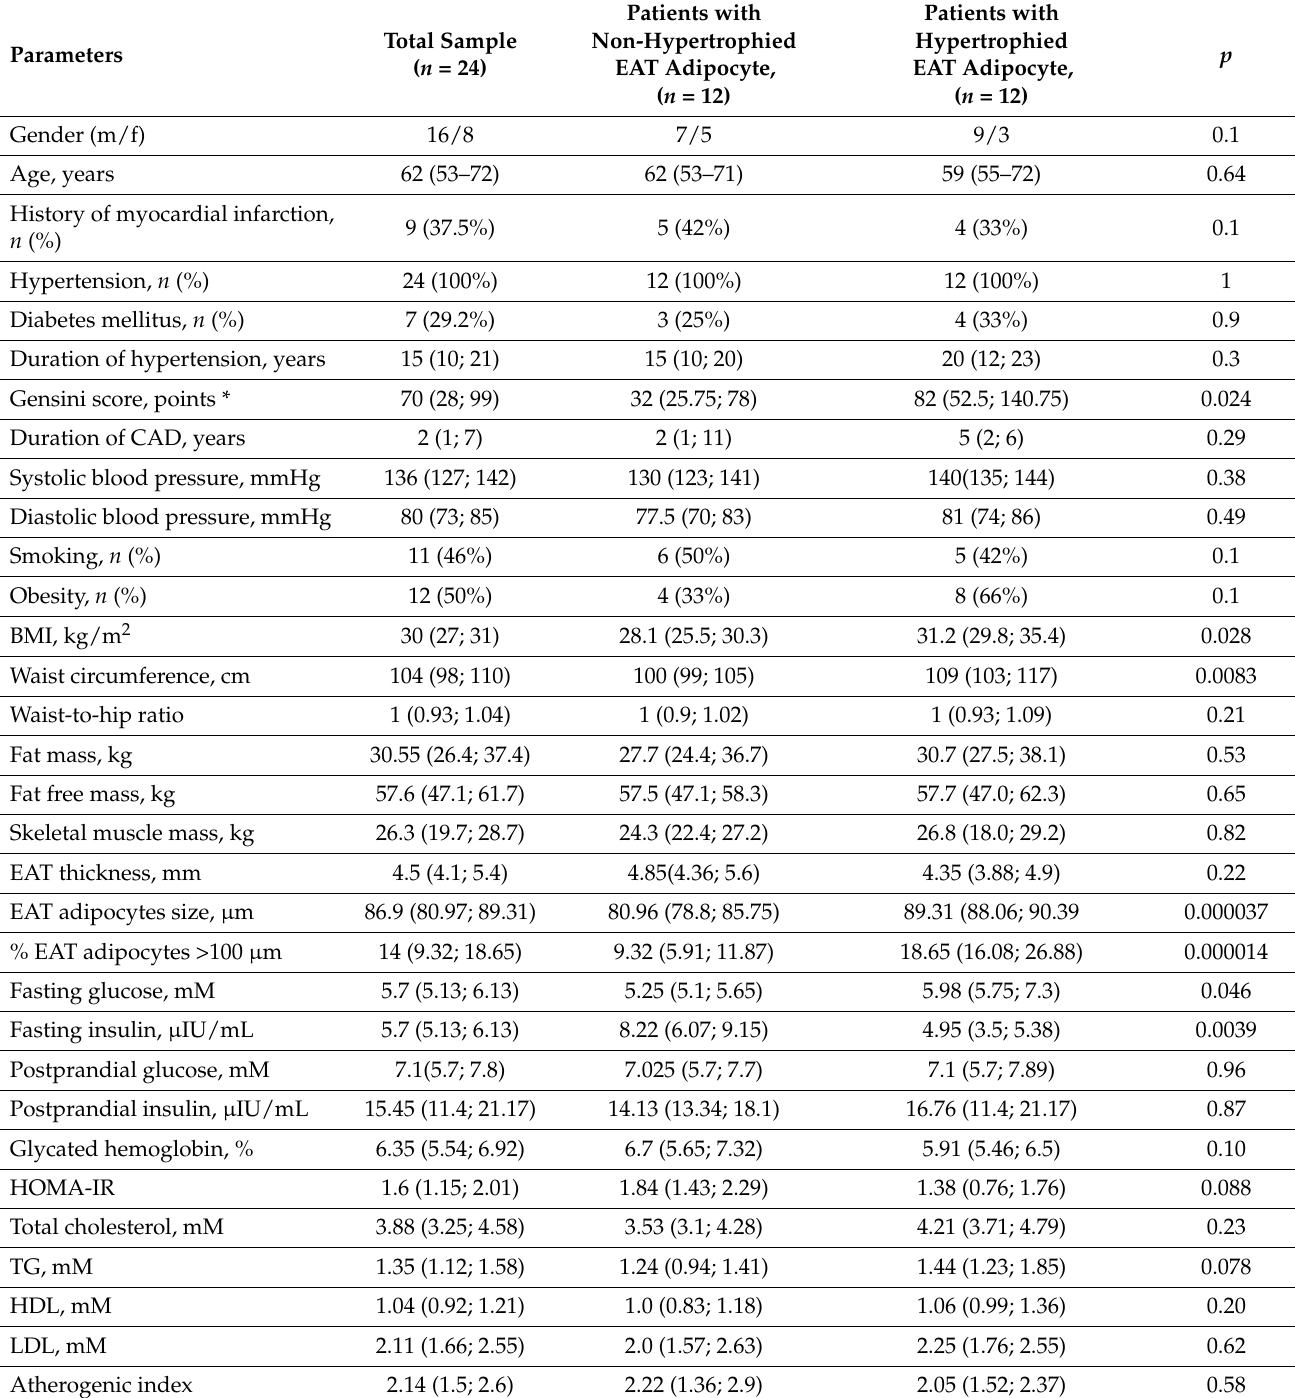
Table 1. Clinical characteristics of patients depending on the hypertrophy of adipocytes of epicardial adipose tissue.